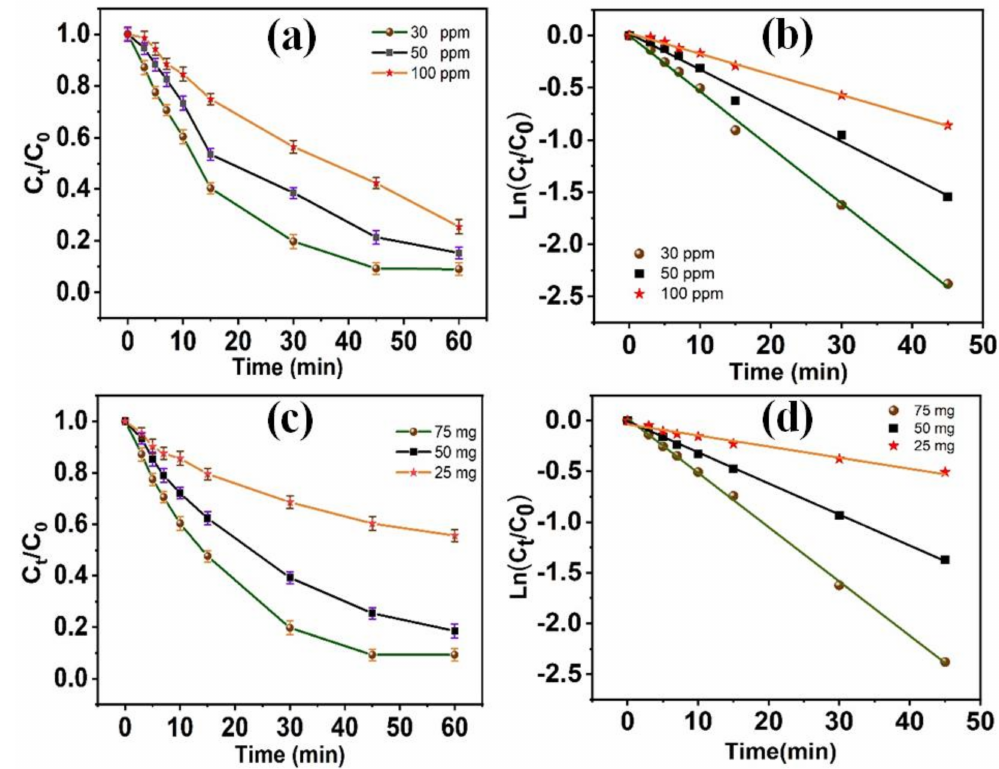
Figure 9. Photocatalytic efficiency of methylene blue dye at various concentrations ( a , b ) and different Ru-ZnO@g-C 3 N 4 mass concentrations ( c , d